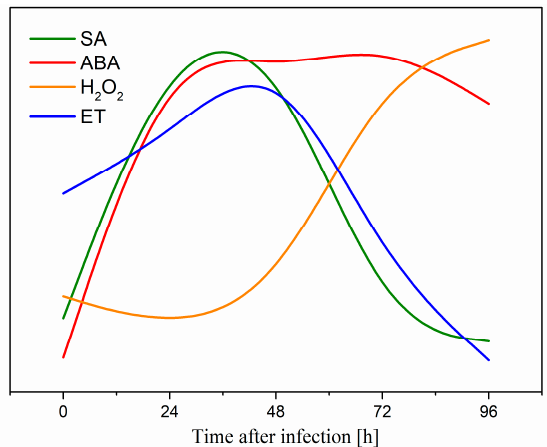
Figure 8. A summary of the dynamics of the accumulation of salicylic acid (SA), abscisic acid (ABA), hydrogen peroxide (H 2 O 2 ) and ethylene (ET) molecules in in vitro cultured embryo axes of Lupinus luteus infected with Fusarium oxysporum f. sp. lupini .